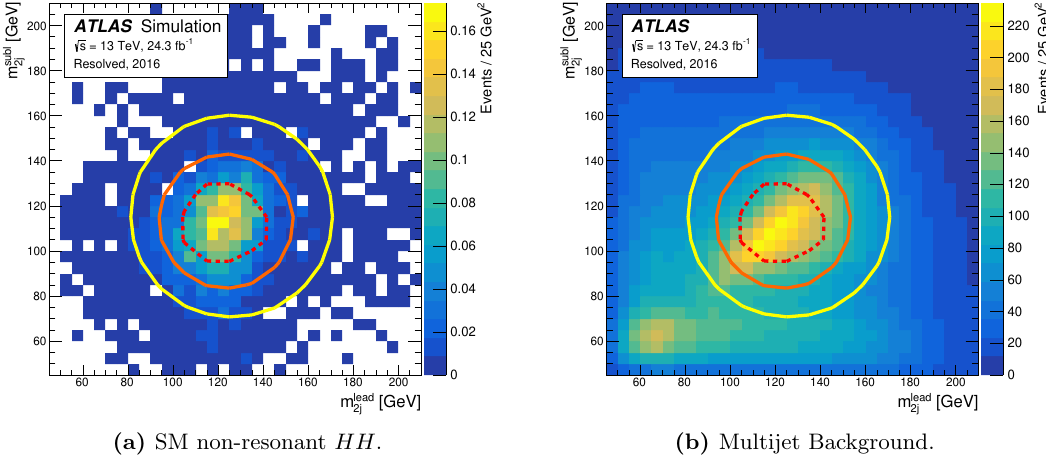
Figure 1. Higgs boson candidate mass-plane regions. The signal region is inside the inner (red) dashed curve, the control region is outside the signal region and within the intermediate (orange) circle, the sideband is outside the control region and within the outer (yellow) circle. (a) shows the SM non-resonant HH process, and (b) shows the estimated multijet background, which is described in section